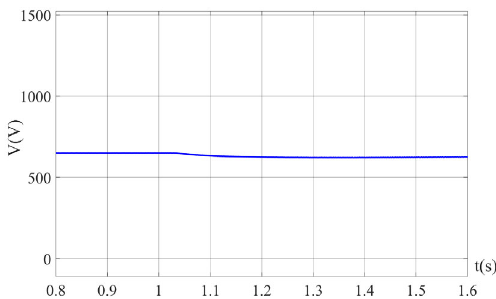
Figure 9. The DC bus side voltage (Group A).